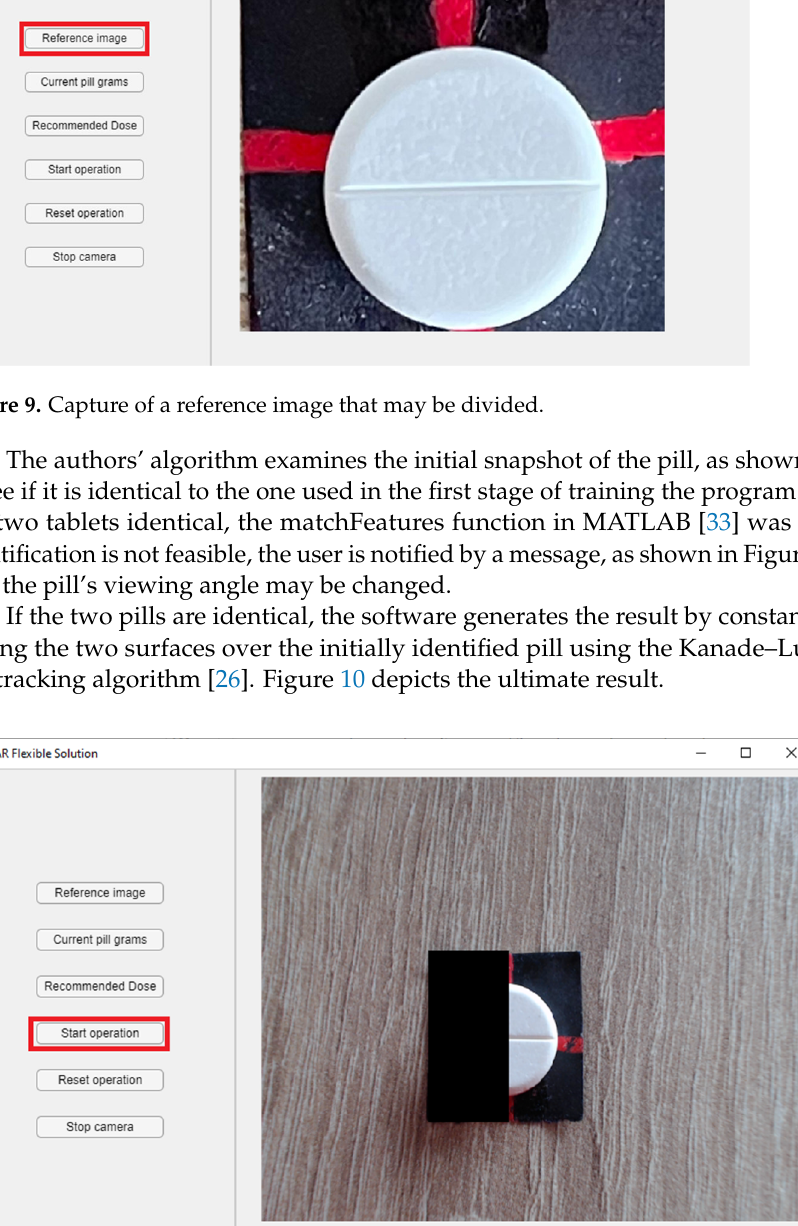
Figure 10. The result was obtained using the new flexible solution proposed in this paper. To protect privacy, the user can turn off the camera by hitting the “Stop camera” button.